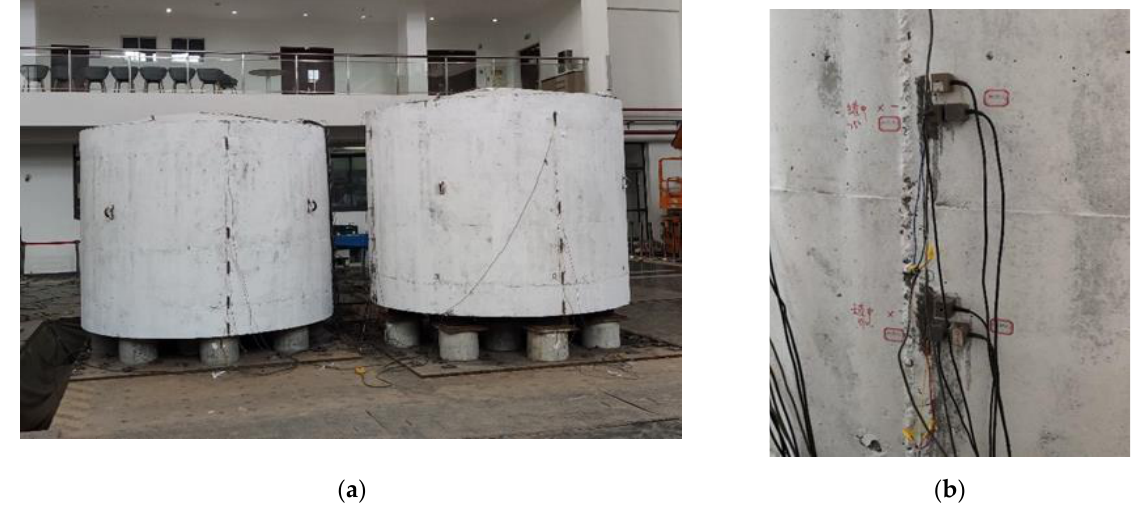
Figure 2. ( a ) Test model of the storage tank; ( b ) layout of the acceleration sensor.